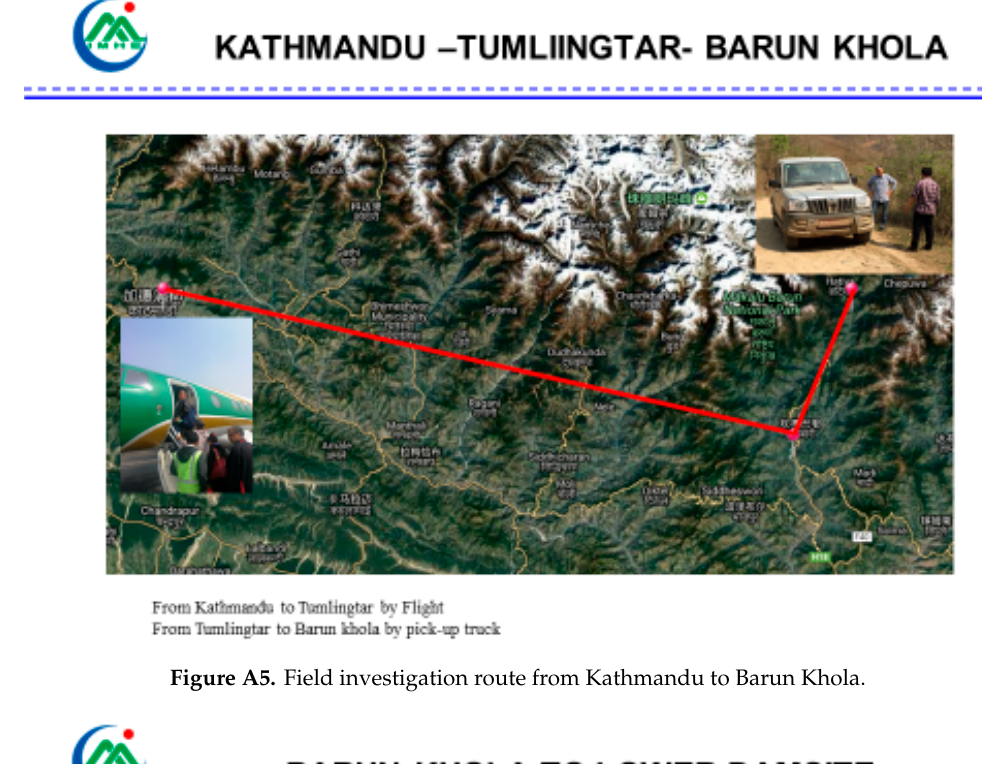
Figure A5. Field investigation route from Kathmandu to Barun Khola .